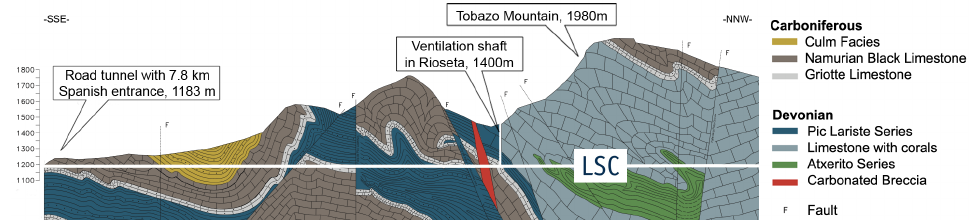
Figure 2. Laboratorio Subterráneo de Canfranc (LSC)—Longitudinal geological profile.